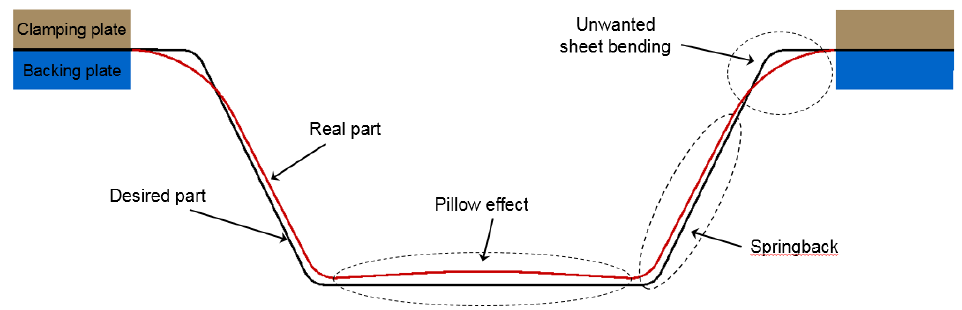
Figure 1. Main types of errors identified in parts machined by single-point incremental forming (SPIF).